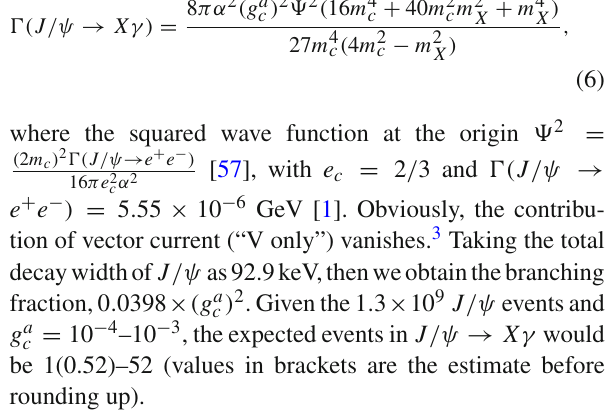
olution of δ E = 2 , 4 , 5 MeV (Fig. 5b–d) respectively. Note, signal events would be suppressed by two orders of magnitude when